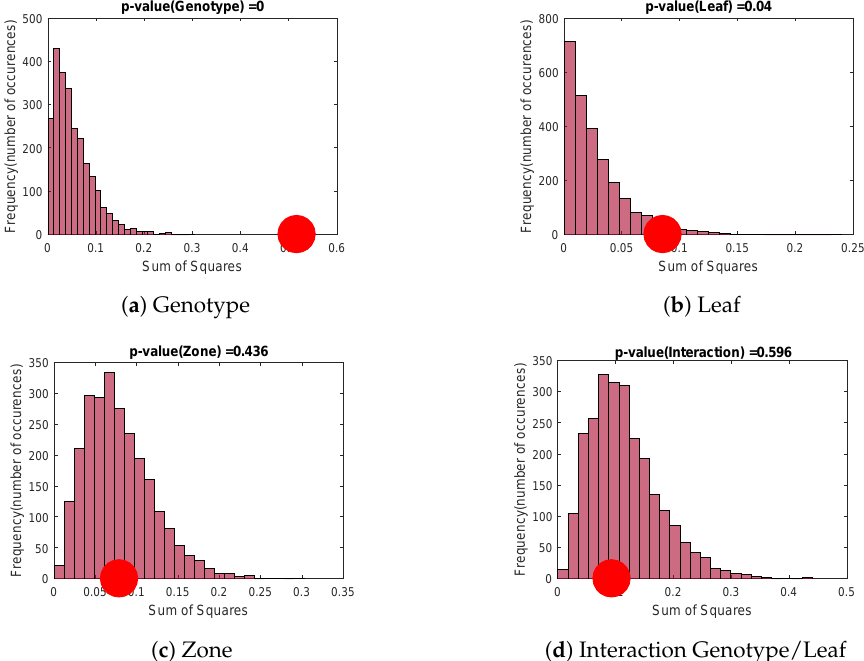
Figure 6. Permutation tests: comparison of the factor variance (red dot) with variances obtained by random permutations of level assignments.